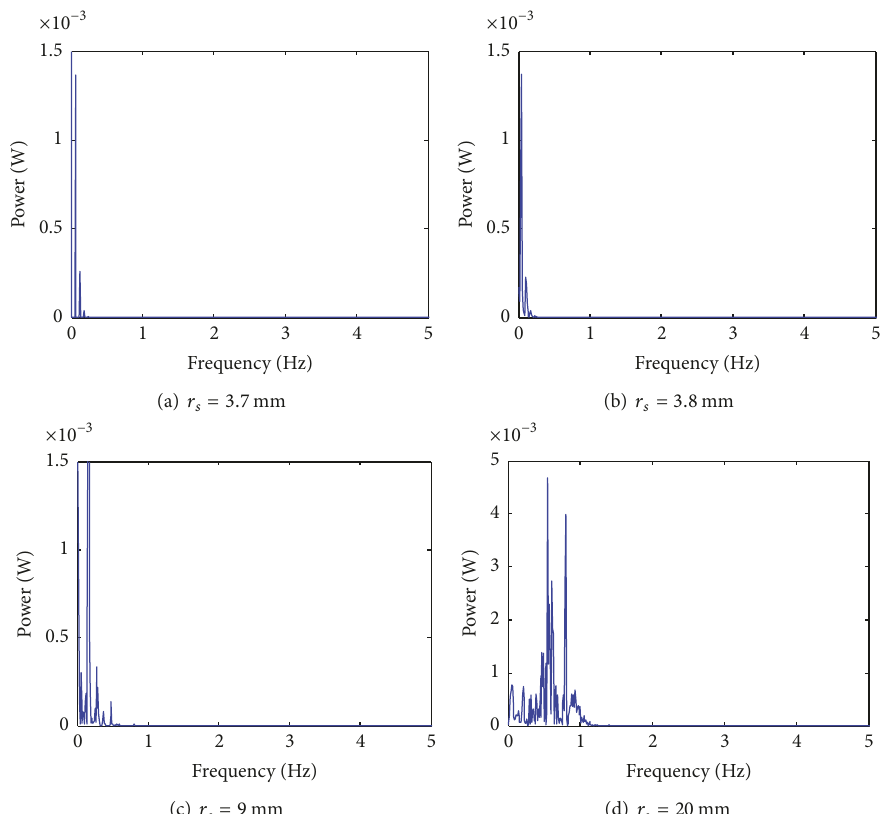
Figure 10: Power spectrum of vibration response of wave generator for different theoretical radius.